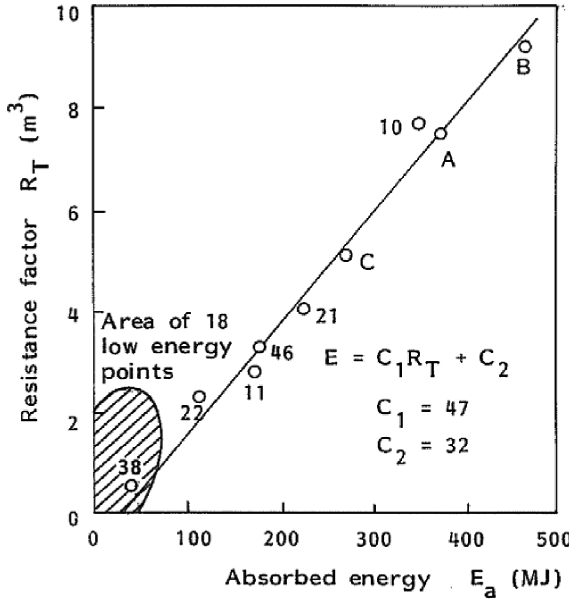
Fig. 1. Correlation between energy absorbed in collision and volume of damaged material – Minorsky